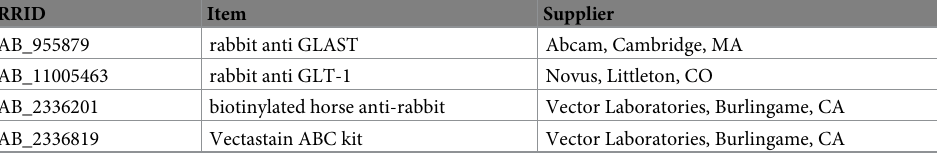
Table 1. List of antibodies and reagents used for dot blot experiments. The table lists the RRID number of antibodies and reagents used for dot blot analysis. RRID Item Supplier AB_955879 rabbit anti GLAST Abcam, Cambridge, MA AB_11005463 rabbit anti GLT-1 Novus, Littleton, CO AB_2336201 biotinylated horse anti-rabbit Vector Laboratories, Burlingame, CA Vector Laboratories, Burlingame,